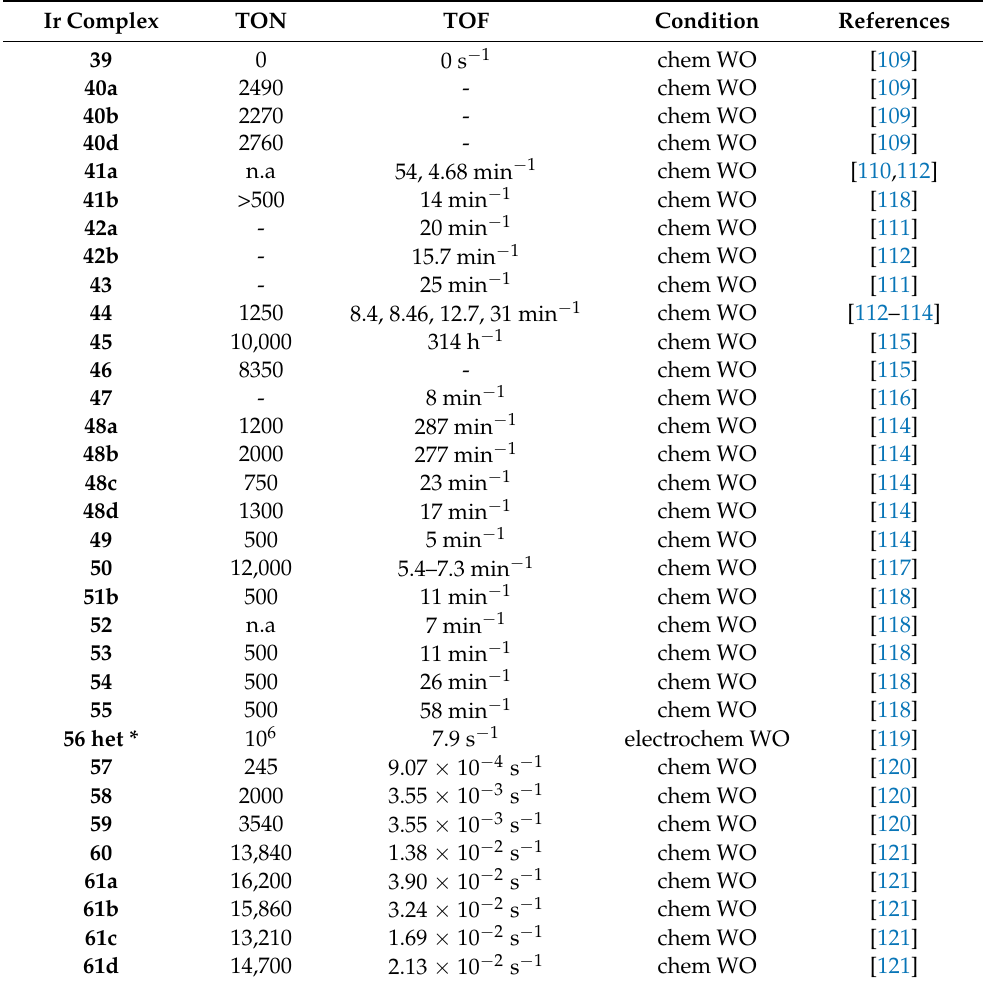
Table 4. Selected catalytic parameters and experimental conditions for Ir catalysts 39–61 for water oxidation. Electrochemical and chemical water oxidation using CAN are abbreviated as ‘electrochem WO’ and ‘chem WO’, respectively. The TON or TOF values that are not listed in this table are unavailable in